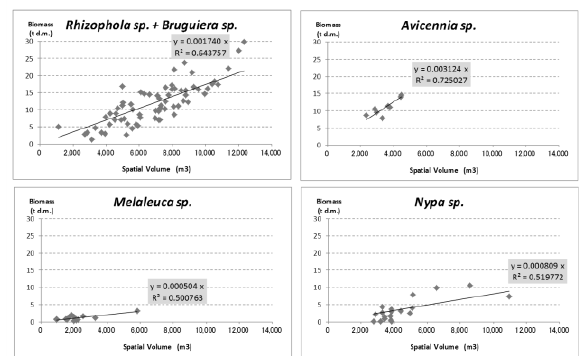
Figure 6 . The result of correlation analysis